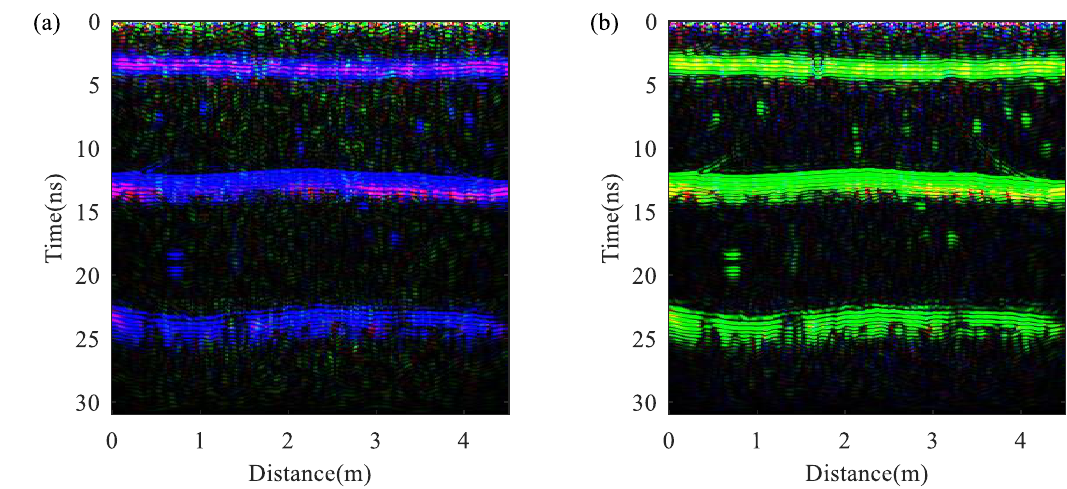
Figure 6. The RGB image obtained by Pauli decomposition. ( a ) The single scattering mechanism is shown in blue. ( b ) The single scattering mechanism is shown in green.